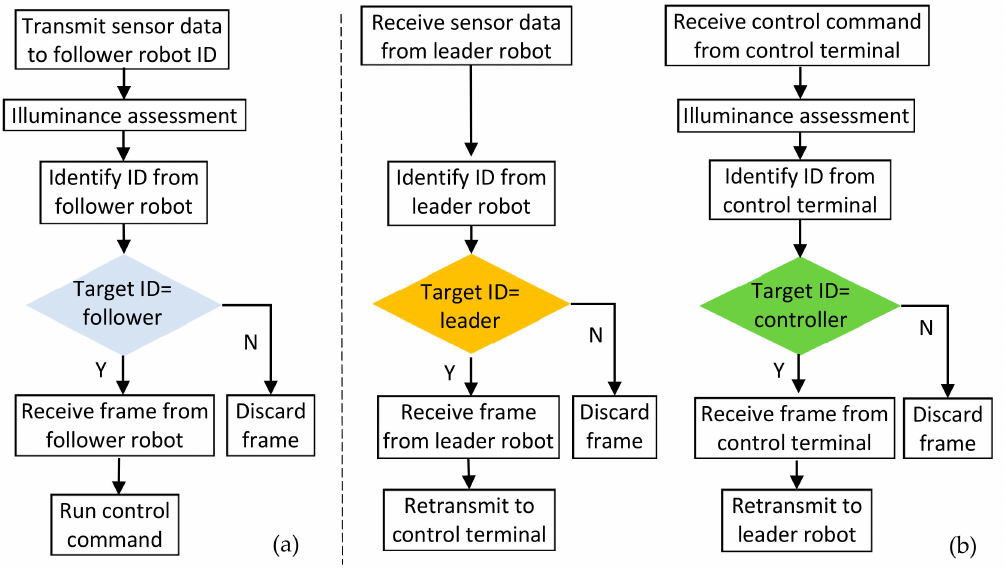
Figure 8. Relay frame routing of ( a ) leader robot and ( b ) follower